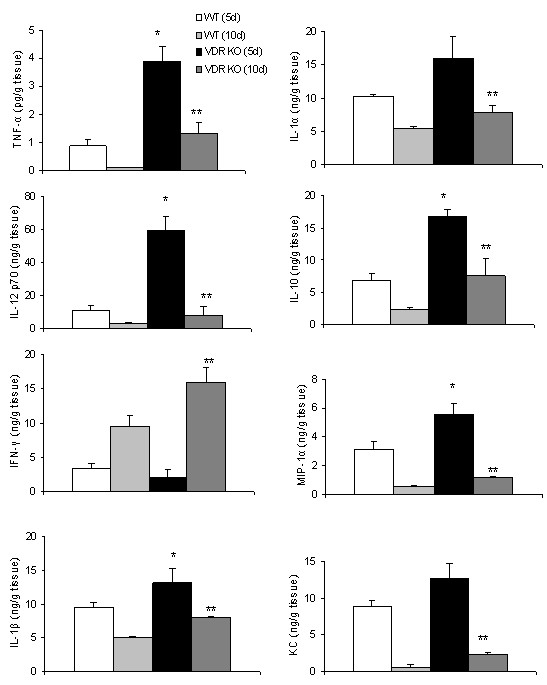
Cytokine and chemokine production after DSS-induced colitis. TNF-α, IL-12, IFN-γ IL-1α, IL-1β, IL-10, MIP-1α, KC protein expression in colonic homogenates. * VDR KO values were significantly different than WT mice at 5 days or ** 10 days post-DSS.